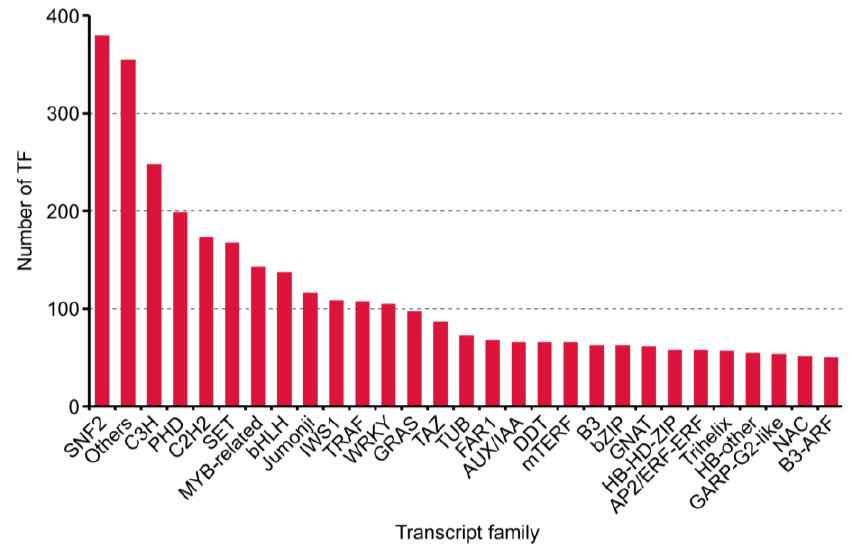
Figure 5. Numbers and families of the top 30 transcript factors (TFs) predicted by iTAK software in purslane ( Portulaca oleracea ).